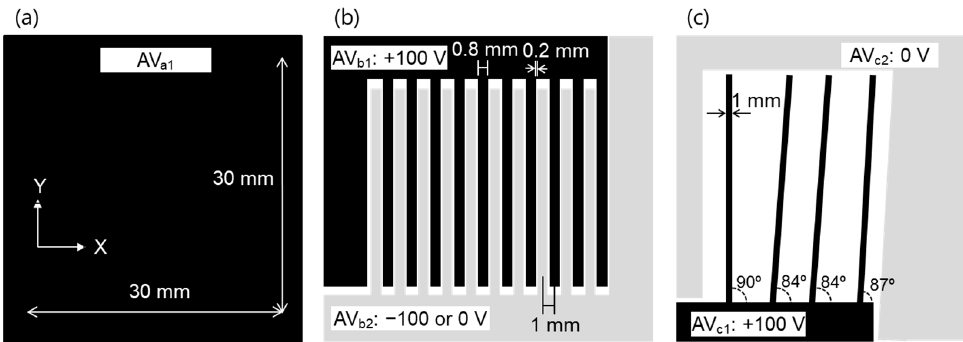
Figure 2. Shape of ( a ) test sample 1, ( b ) test sample 2, and ( c ) test sample 3.